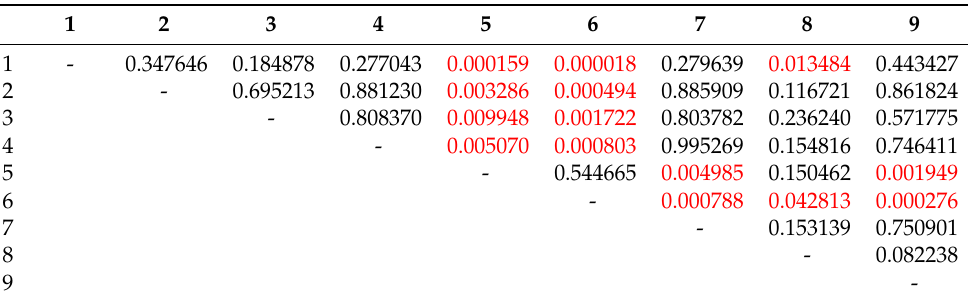
Figure A5. Box-and-whisker plot of diametral tensile strength (DTS) of tested composites (UDMA/Bis-GMA/TEGDMA 70/10/20 wt.% and 40/40/20 wt.% and UDMA/Bis-EMA/TEGDMA 40/40/20 wt.%) after selected ageing protocols (control-water, 24 h, 37 ◦ C; thermocycling + NaOH- water, 7500 thermo cycles, 5/55 ◦ C and 0.1 M NaOH, 7 days, 60 ◦ C; 5d water + NaOH-water, 5 days, 55 ◦ C and 0.1 M NaOH, 7 days). Significant differences occur in a given group with a probability of p < 0.01 (*) and/or p < 0.05 (**). Table A4. Probabilities for post hoc testing for diametral tensile strength (DTS) of tested composites. Tested group: 1-UDMA/bis-GMA/TEGDMA 70/10/20, control; 2-UDMA/bis-GMA/TEGDMA 70/10/20, thermocycling +NaOH, 3-UDMA/bis-GMA/TEGDMA 70/10/20, 5d water + NaOH, 4-UDMA/bis-GMA/TEGDMA 40/40/20, control; 5-UDMA/bis-GMA/TEGDMA 40/40/20, ther- mocycling +NaOH; 6-UDMA/bis-GMA/TEGDMA 40/40/20, 5d water + NaOH; 7-UDMA/bis- EMA/TEGDMA 40/40/20, control; 8-UDMA/bis-EMA/TEGDMA 40/40/20, thermocycling +NaOH, 9-UDMA/bis-EMA/TEGDMA 40/40/20, 5d water + NaOH.